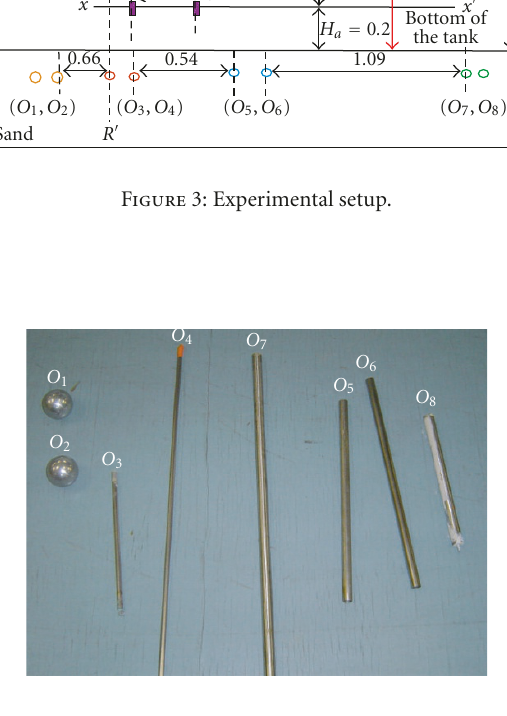
fluid is water or air with density D 3air = 1 . 2 10 − 6 kg/m 3 or D = 1000 kg/m 3 3water